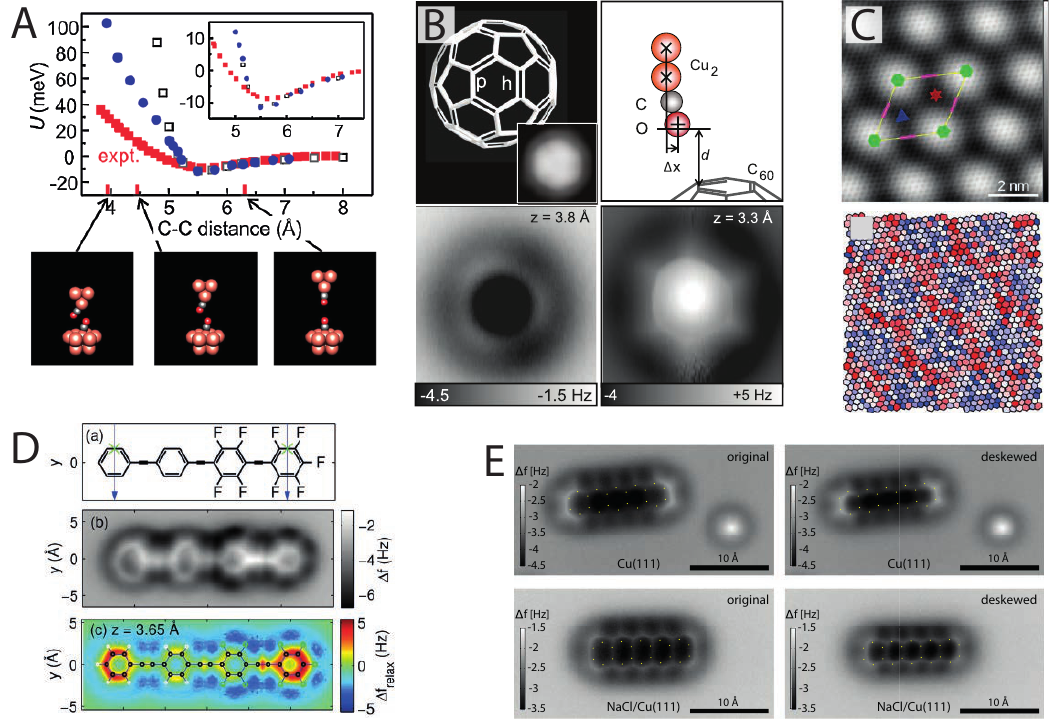
Figure 2. The effect of tip flexibility in high-resolution imaging. ( A ) CO bending observed in measurements of the CO–CO molecular pair potential (reprinted with permission from [55], copyright 2011 by the American Physical Society); ( B ) NC-AFM images showing bond length enhancement and sharpening due to flexibility at very small tip-sample distances (from [29], reprinted with permission from AAAS); ( C ) NC-AFM image showing variations in carbon ring size due to corrugation of Ir(111)-supported graphene (reprinted with permission from [56], copyright 2014 by the American Chemical Society); ( D ) Measurement and simulation of image distortions observed in NC-AFM images of 4-(4-(2,3,4,5,6-pentafluorophenylethynyl)-2,3,5,6-tetrafluorophe-nylethynyl) phenylethynylbenzene (FFPB) (reprinted with permission from [53], copyright 2014 by the American Chemical Society); ( E ) Image correction from lateral force analysis for pentacene imaged with NC-AFM on Cu(111) and NaCl (2 ML)/Cu(111) (reprinted with permission from [57], copyright 2014 by the American Physical